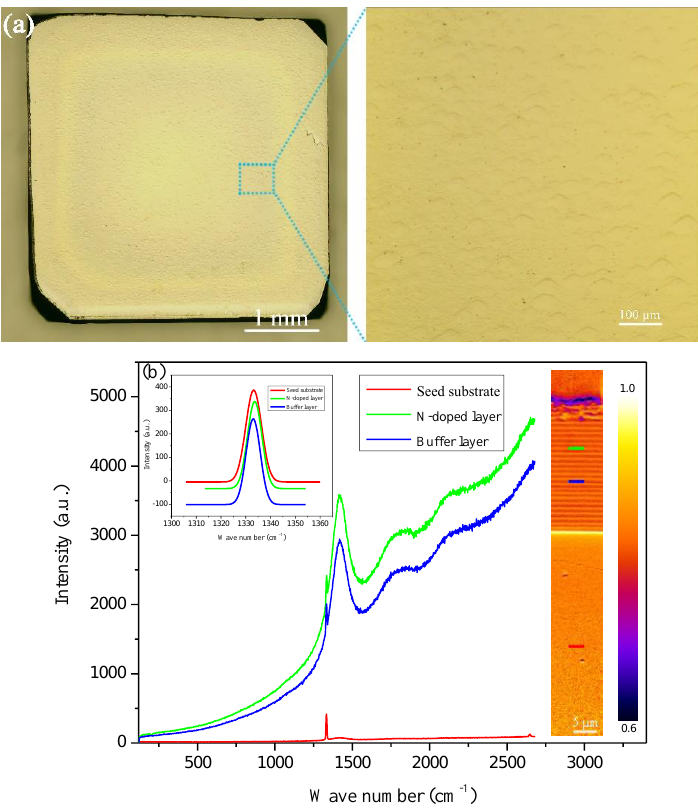
Figure 7. ( a ) Surface morphology of sample 2. ( b ) Raman scan of the cross section of sample 2 showing the presence of alternating thin nitrogen-doped and buffer layers. The inset shows the Raman spectra of the first-order phonon peak of diamond in different positions.